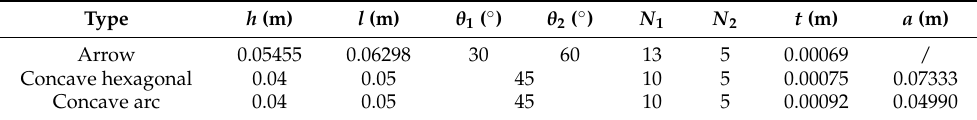
Table 1. Dimensions of each unit cell of the honeycomb